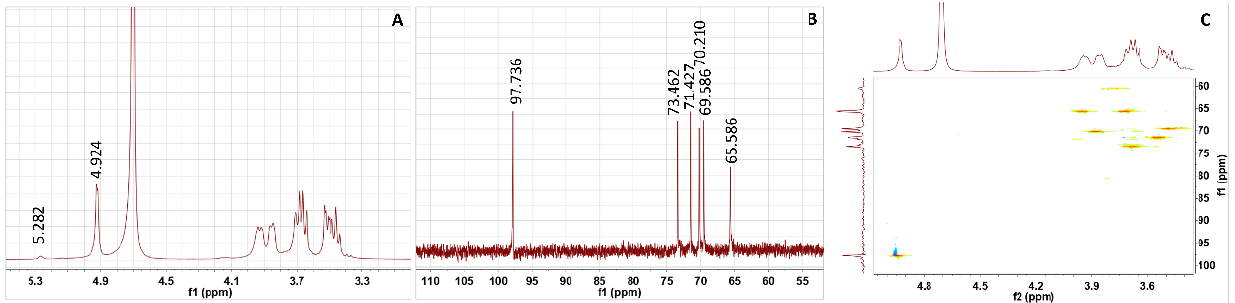
Figure 3. Nuclear magnetic resonance (NMR) spectrum of dextran. ( A ) 1 H spectrum; ( B ) 13 C spectrum; ( C ) HSQC spectrum.